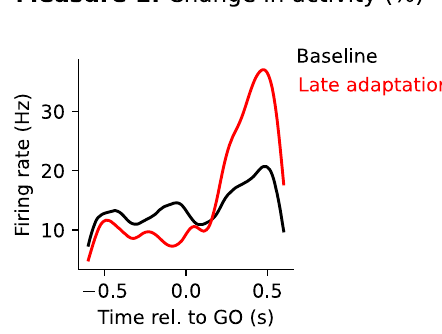
Fig. 1 | Competing hypotheses to explain where learning happens during a visuomotor rotation task. A To study the processes mediating motor cortical activity changes during adaptation in a visuomotor rotation task, we analyze and model the activity of neural populations within dorsal premotor cortex (PMd) and primary motor cortex (M1). We compare two hypotheses: plasticity upstream of